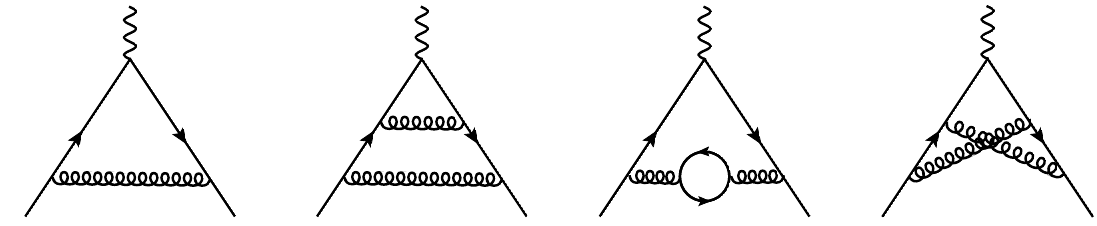
Figure 2. Sample diagrams contributing to F 1 and F 2 at one and two loops. Solid, curly and wavy lines represent quarks, gluons and photons,